Question: Express in one sentence what the figure is showing.
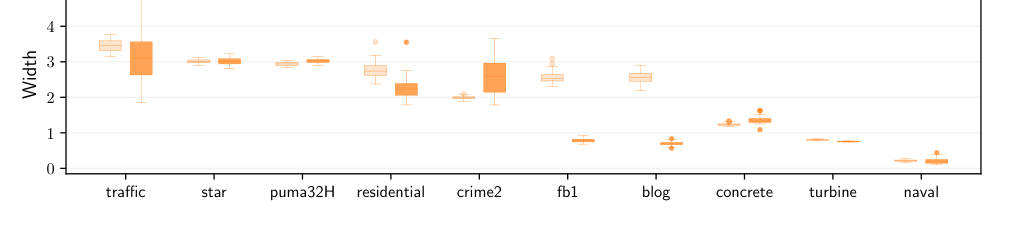
Answer: 10: The coverage degree of the confidence predictors and data sets from Section 3.4.3. For each model, two versions are shown: one trained on the full training set, indicated by ‘Full’, and one trained on half of it (corre- sponding to the conformalized models), indicated by ‘CP’. The data sets are sorted along the 𝑥-axis in order of increasing 𝑅2-coeﬀicient of the conformal- ized model.